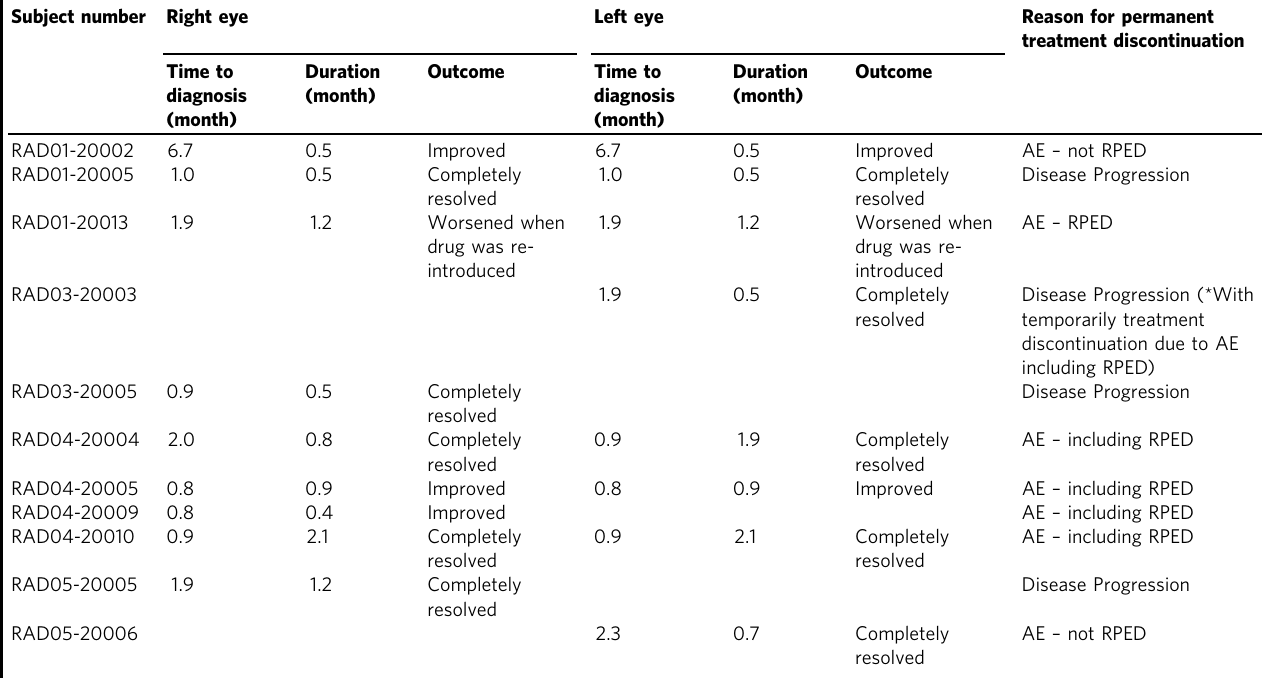
Table 3 Description of RPEDs (retinal pigment epithelial